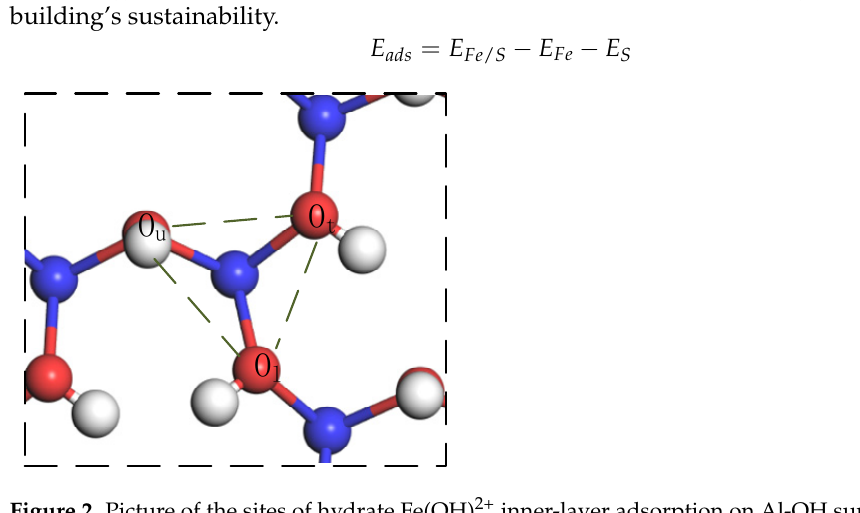
O l Figure 2. Picture of the sites of hydrate Fe(OH) 2+ inner ‐ layer adsorption on Al ‐ OH surface.